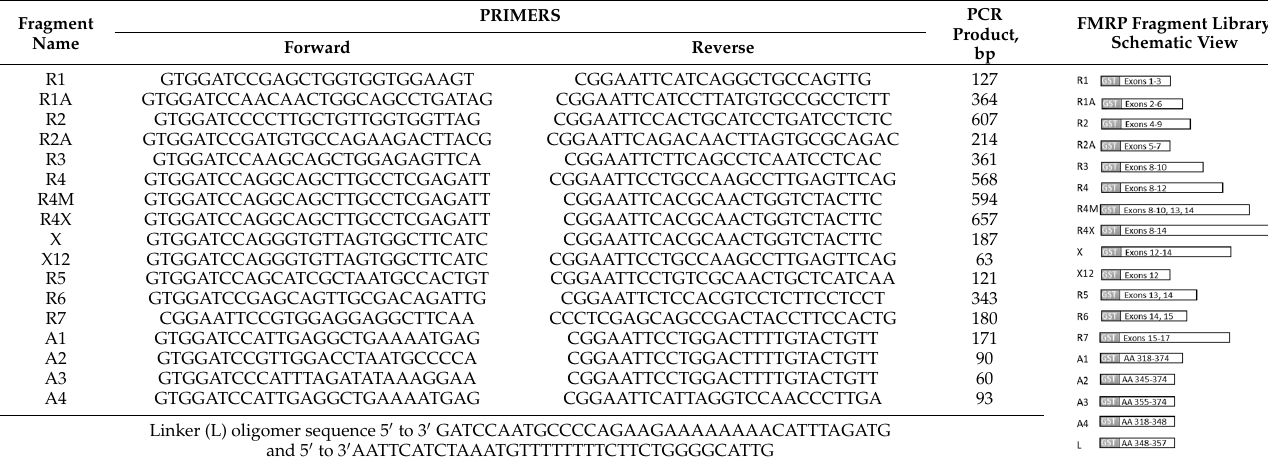
Table 1. Recombinant FMRP fragment library.